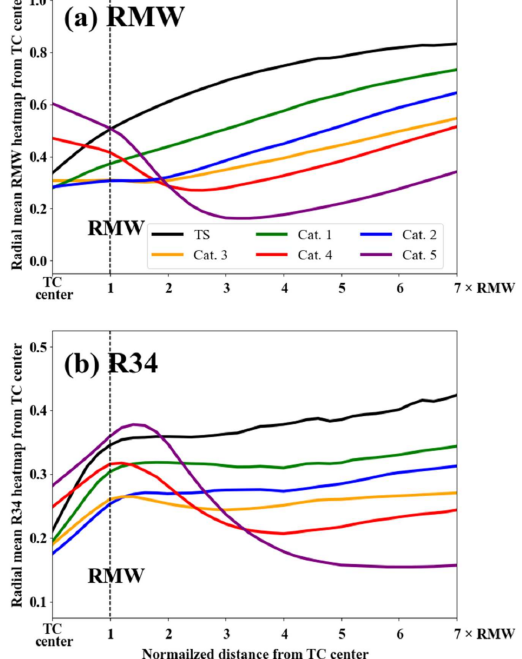
Figure 11. Radial mean heatmaps from the center of the tropical cyclone (TC) for ( a ) the radius of maximum wind (RMW) and ( b ) the radius of 34 kt wind (R34) estimated for TCs of each category on the Saffir–Simpson Hurricane Wind Scale. The x-axis is the distance normalized by the RMW (i.e., 1 is the RMW, 2 is twice the RMW,